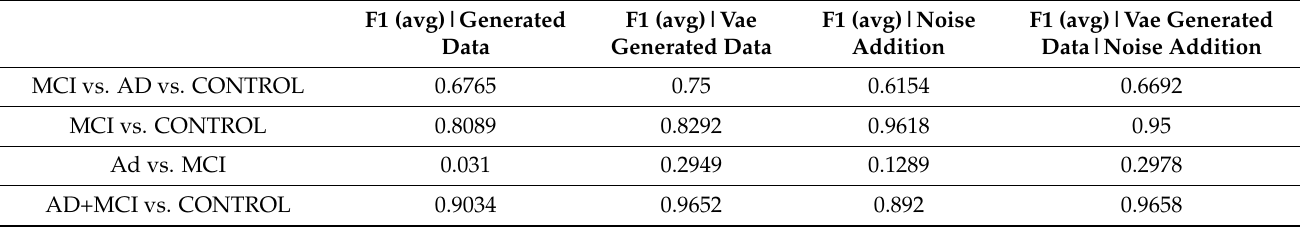
Figure 3. Comparison of results for 5 s (F1).